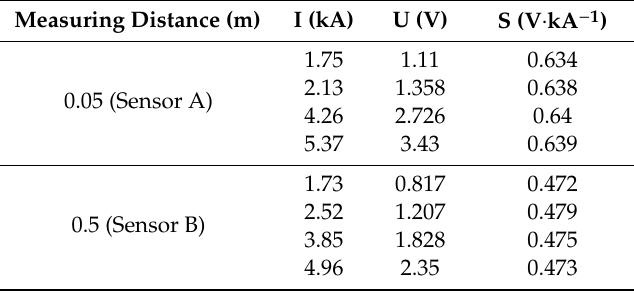
Table 2. Response of the optical current sensor